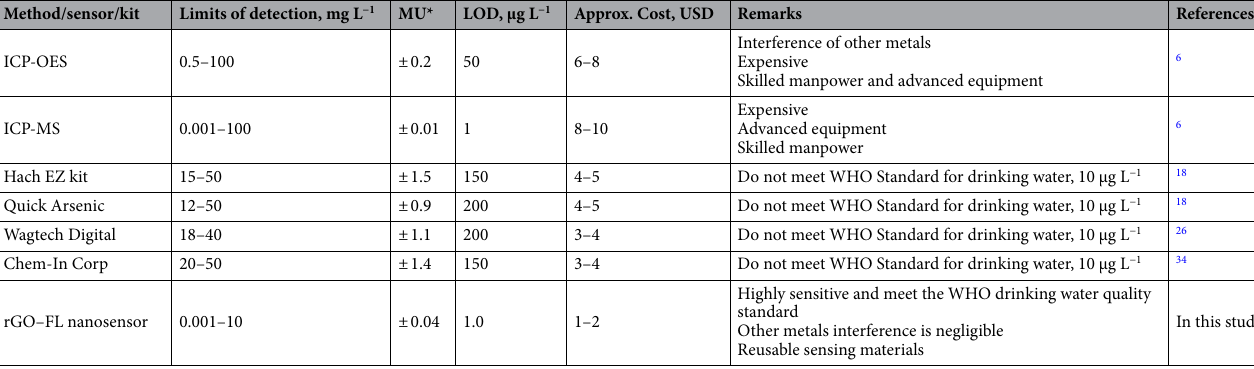
Table 2. Comparison of performance and cost of As(III) determination using various recently reported methods/sensors and field kits. *MU, measurement of uncertainty was calculated according to the procedure given in Ref. 13 . The number of samples which were tested was 5. Out of 5 samples, 2 samples were reagent water spiked with As(III) standard of different concentrations and remaining 3 samples collected from different locations in India. Each sample was tested repeatedly for seven times (n = 7).